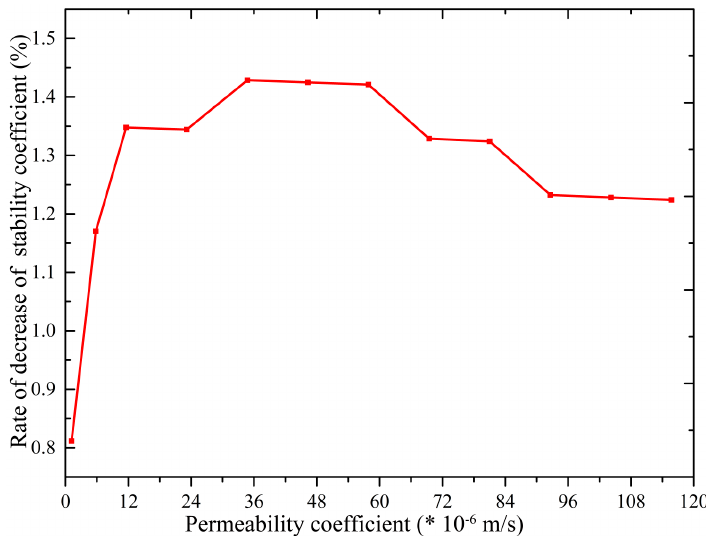
Figure 13. RDSC for different permeability coefficients under rainstorm conditions.